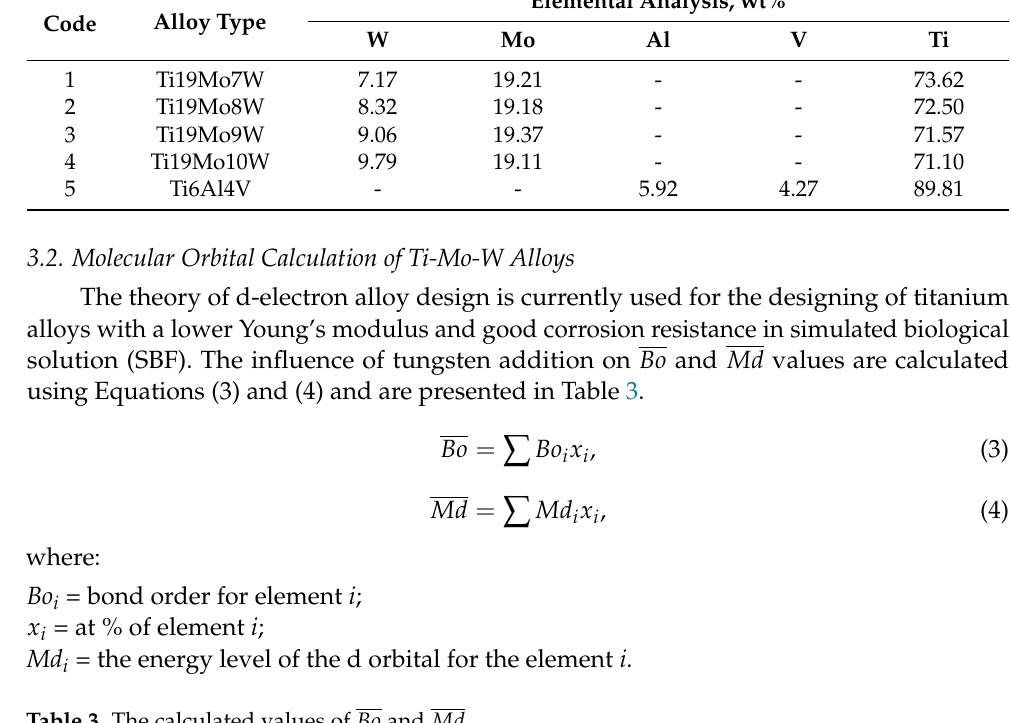
Table 3. The calculated values of Bo and Md